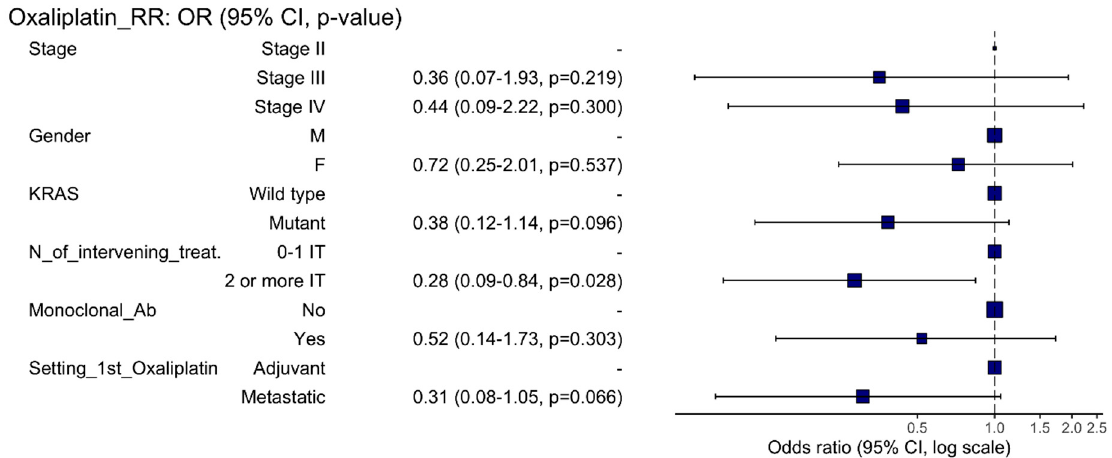
Figure 1. Forest plot depicting the hazard ratios of the multivariate analysis of oxaliplatin retreatment response rate (RR). Keys: M = male; F = female; N = number; Ab = antibody; IT = intervening treatment.